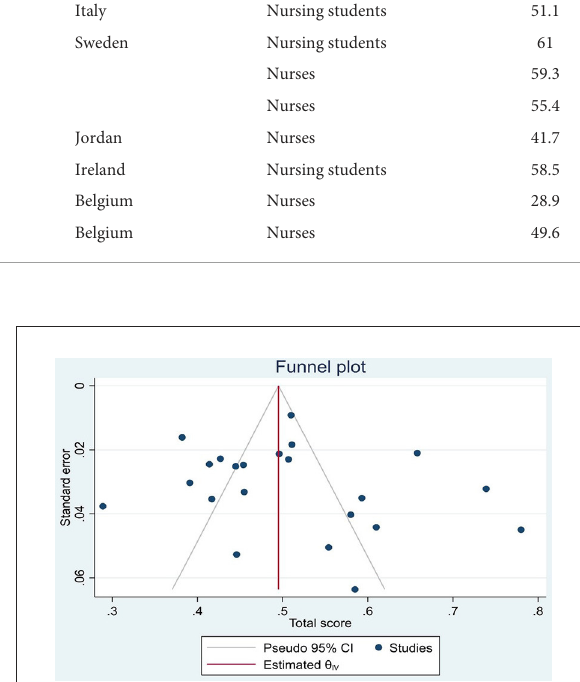
scores in the fifth dimension (preventive measures to reduce the amount of pressure/shear) (Table